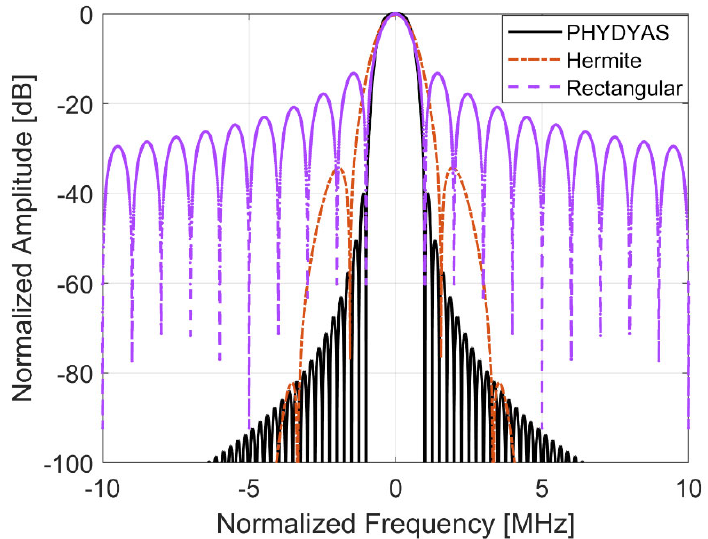
Figure 2. Comparison of three subcarrier prototype filters.